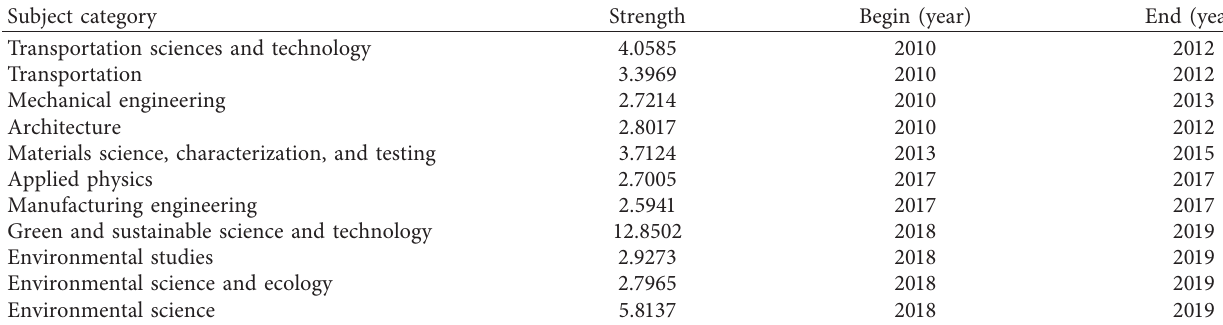
Table 4: Top 11 subject categories with the strongest citation